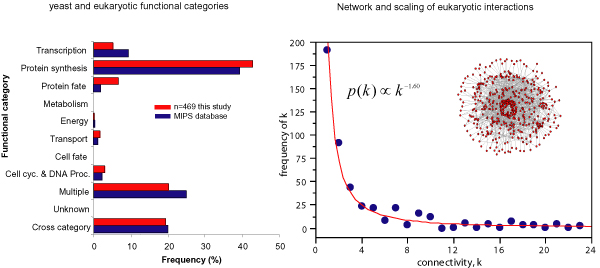
Protein functional categories and protein network. Left panel. A comparison of the proportion of yeast genes (from MIPS database) in various functional categories and the 469 genes in the eukaryotic correlated evolution network. The two sets of proportions are highly correlated (r = 0.95), but proportions do differ (χ2 = 33.8, p < 0.001). Right panel. The correlated evolution network describing 1774 A<=>B connections among the 469 genes, and its connectivity distribution well described by a power-law (r2 = 0.98).